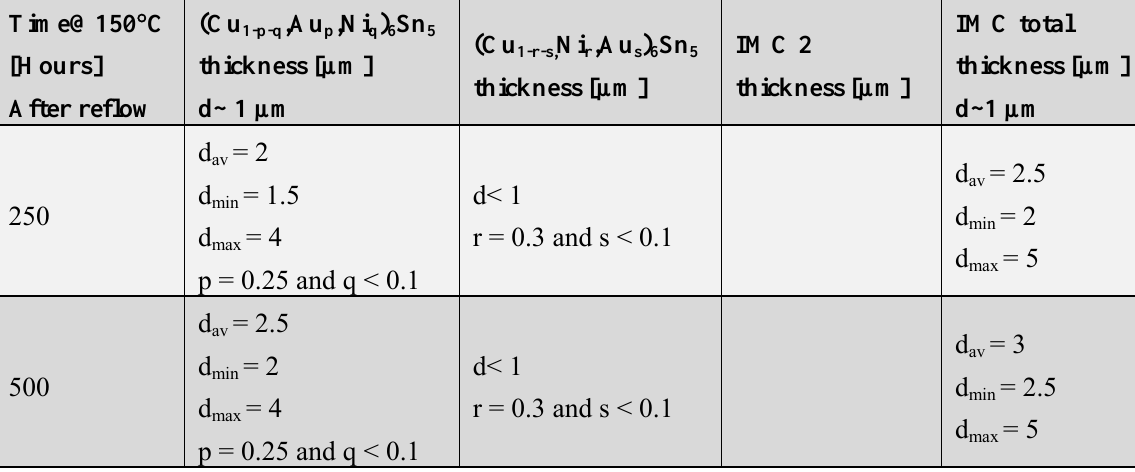
Table 3. Minimum ( d compositions for the phases formed in (SnAgCu)/Ni/Au reaction